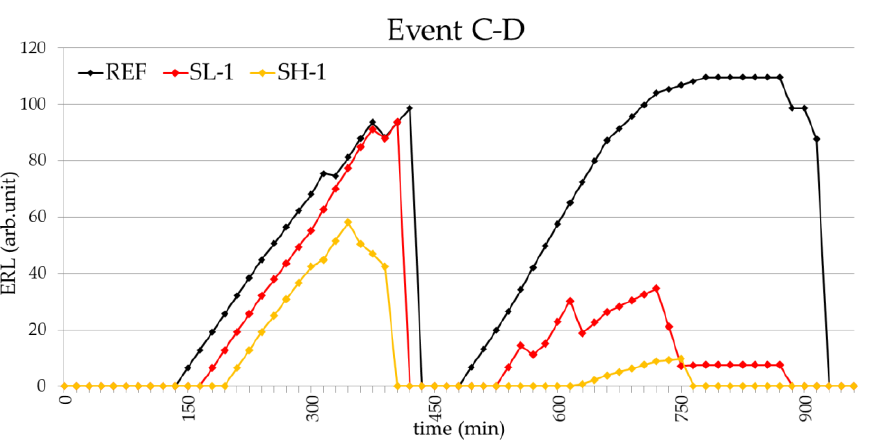
Figure 12. Calculated ERL during the events C and D.